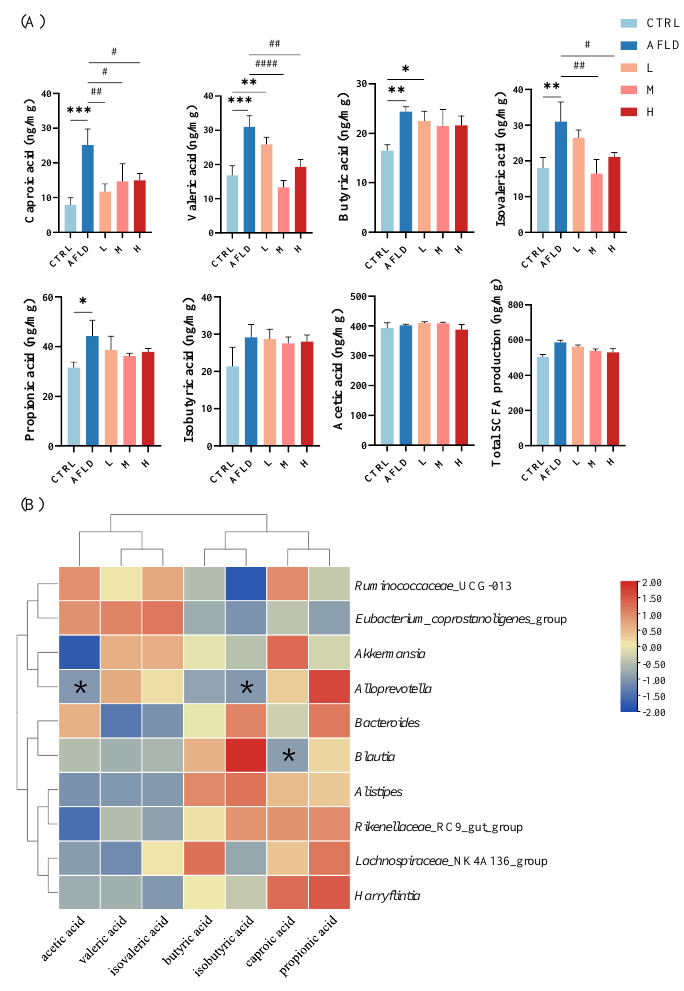
Figure 6. The effects of DOFE on short-chain fatty acid (SCFA) production. ( A ) The contents of SCFAs. CTRL, the control group; AFLD, the model group; L, low concentration; DOFE, Dendrobium officinale flowers extracts; M, medium concentration of DOFE; H, high concentration of DOFE. * p < 0.05, ** p < 0.01, *** p < 0.001 for the CTRL group compared with the AFLD group; # p < 0.05, ## p < 0.01, #### p < 0.0001 for the DOFE high-supplementary group compared with the AFLD group. ( B ) Heatmap of correlation analysis between gut microbiota and SCFAs (* p < 0.05).